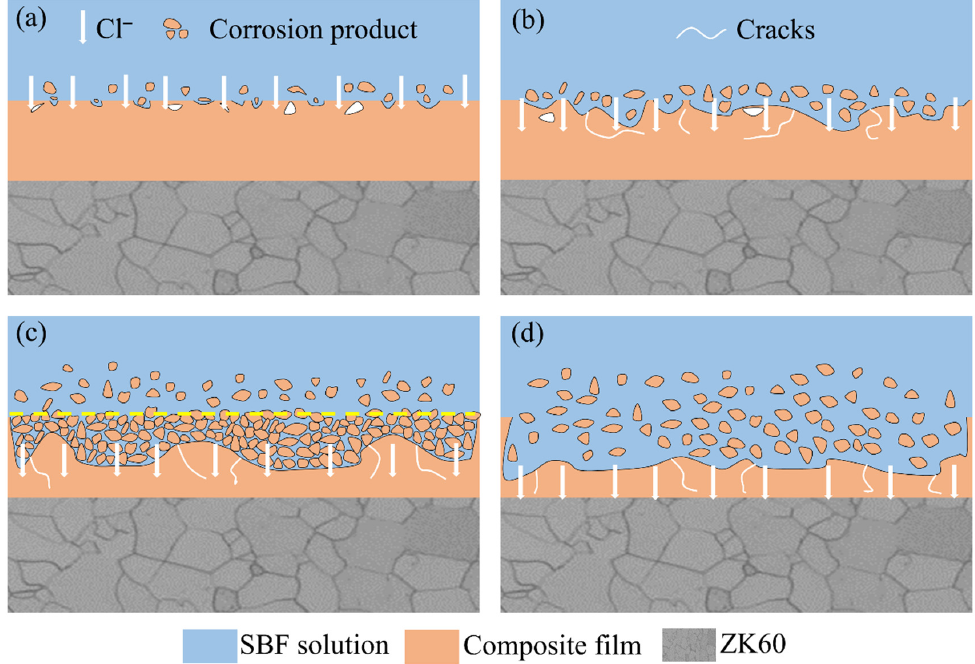
Figure 9. The proposed corrosion protection mechanism model of the hydroxide film. ( a ) Cl − invaded the film, ( b ) Microcracks appeared, ( c ) Numerous corrosion products accumulated, ( d ) Corrosion products fell off